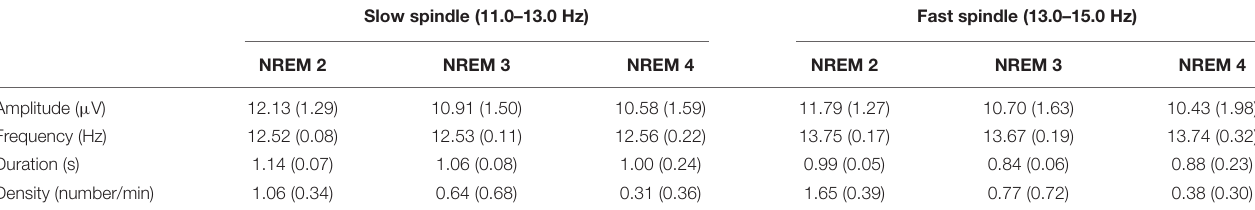
TABLE 3 | Global spindle characteristics.